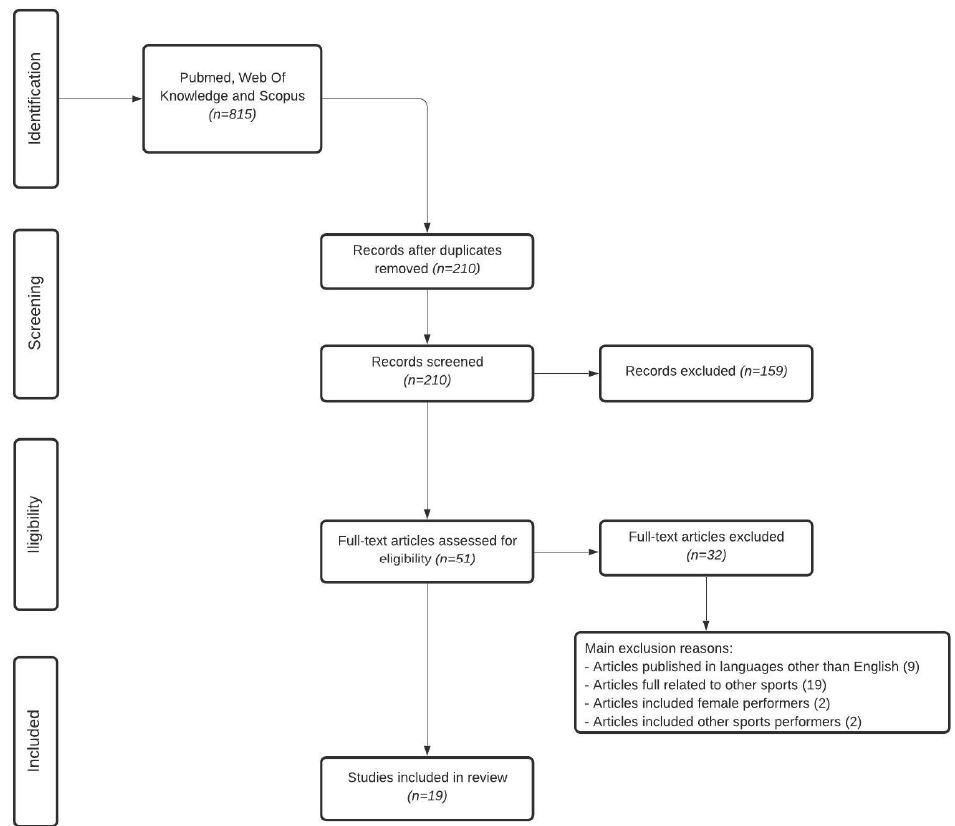
Figure 1. Flow chart of the article’s selection process.